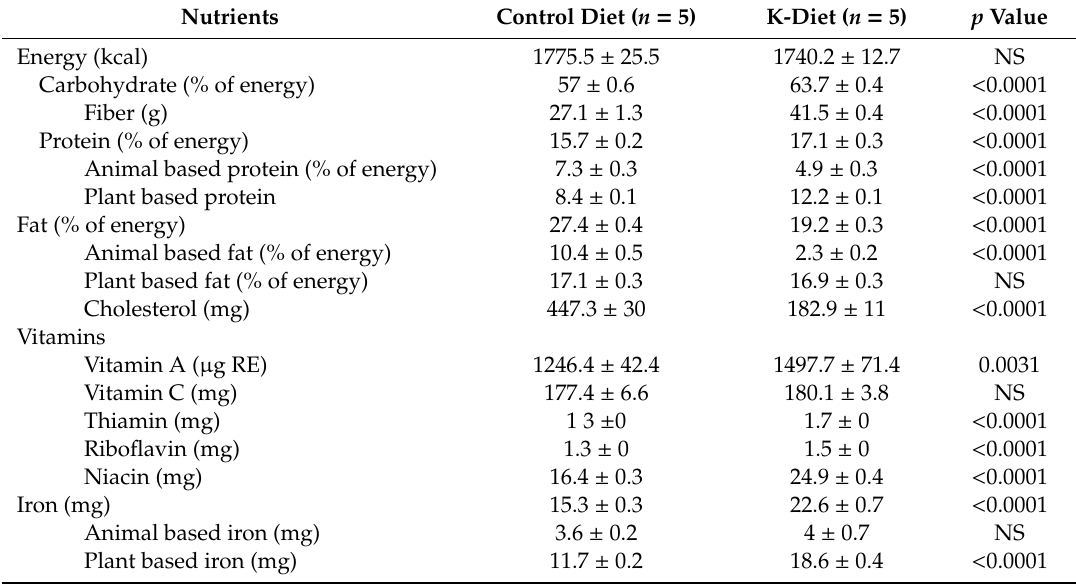
Table 4. Comparison of macro and micro-nutrient intake between control and K-diet group. Nutrients